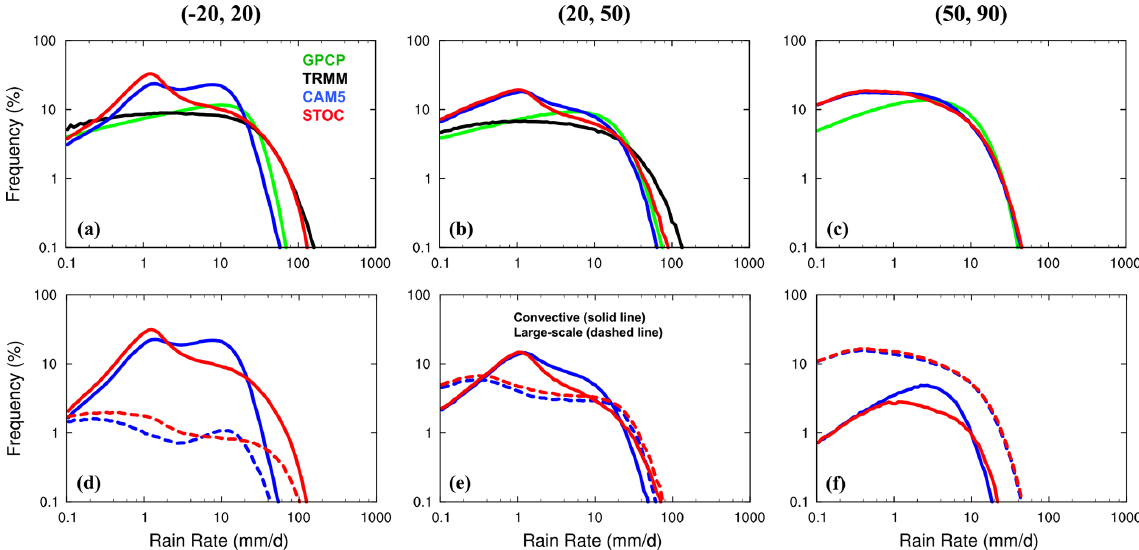
Figure 3. Frequency distributions of (a–c) total and (d–f) convective and large-scale precipitation, over (a, d) 20 ◦ S, 20 ◦ N, (b, e) 20, 50 ◦ N and (c, f) 50, 90 ◦ N. Total rainfall frequency distributions are shown for CAM5 (blue), STOC (red), GPCP (green) and TRMM (black) while convective (solid line) and large-scale (dashed line) rainfall frequency distributions are shown for CAM5 and STOC. The frequency distributions (units: %) are scaled by (cid:49) ln (R) = (cid:49)R/R , which has units of mmd − 1 /mmd − 1 and is a unitless scaling